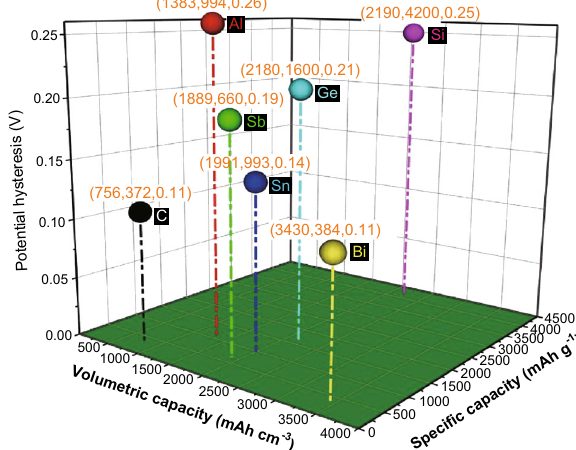
Fig. 1 Lithium storage performances of various metals in compar- ison to